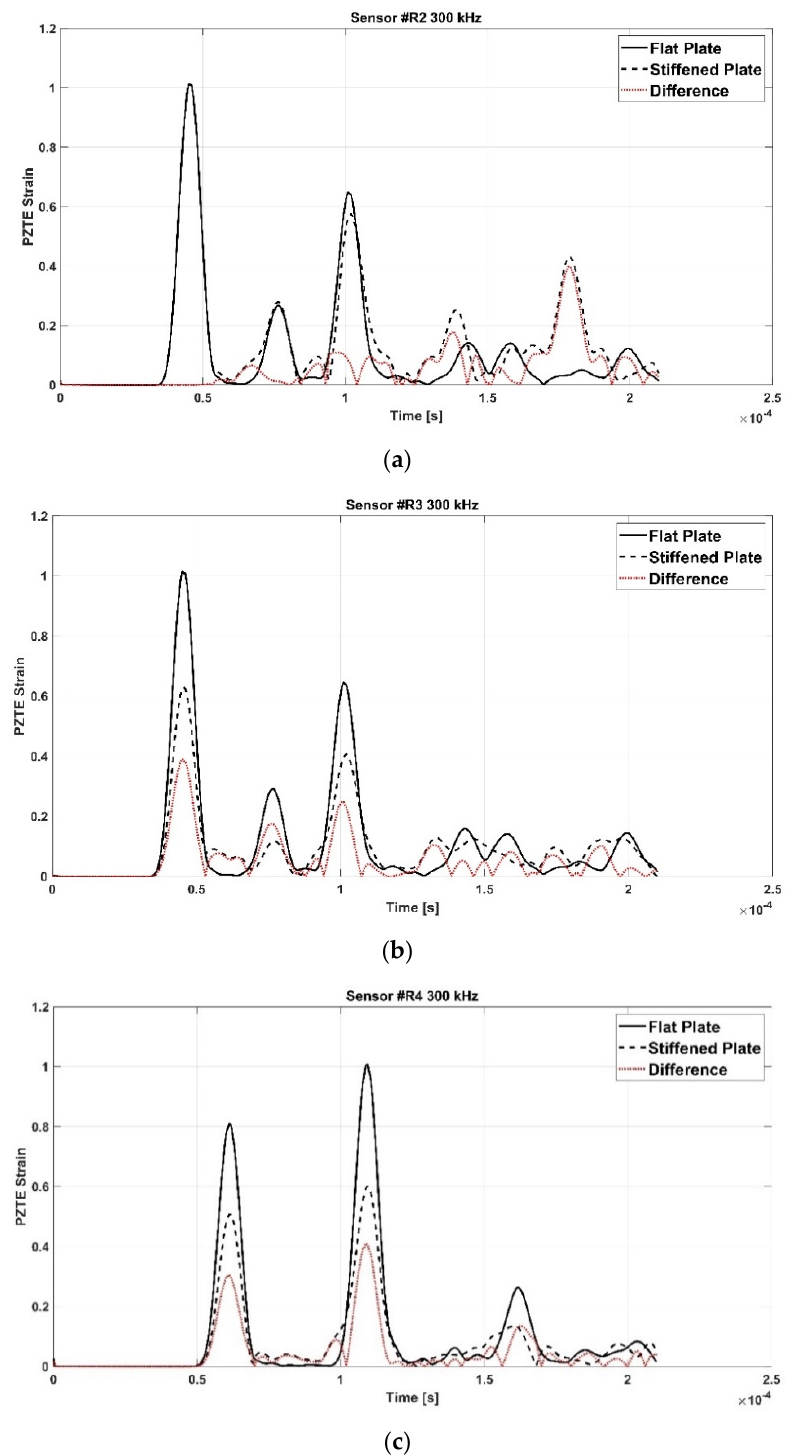
Figure 6. Flat (black solid line), stiffened (black dotted line), and difference (red solid line) signals in aluminum plate under 300 kHz carrier. ( a ) Sensor #R2 300 kHz; ( b ) Sensor #R3 300 kHz; ( c ) Sensor #R4 300 kHz.